Question: Condense the content of this figure into a single sentence.
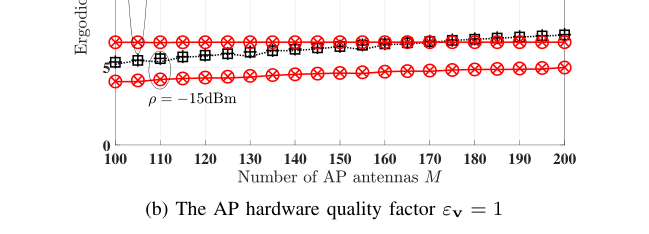
Answer: Theoretical (31), (37) and simulation comparison of the ergodic sum-rate versus the number of AP antennas M.